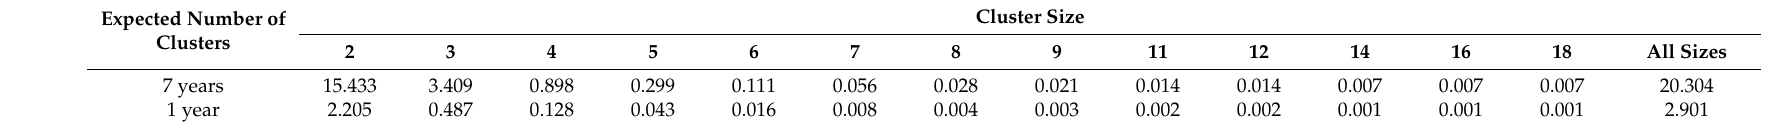
Table 4. Estimated frequencies of clusters for Company